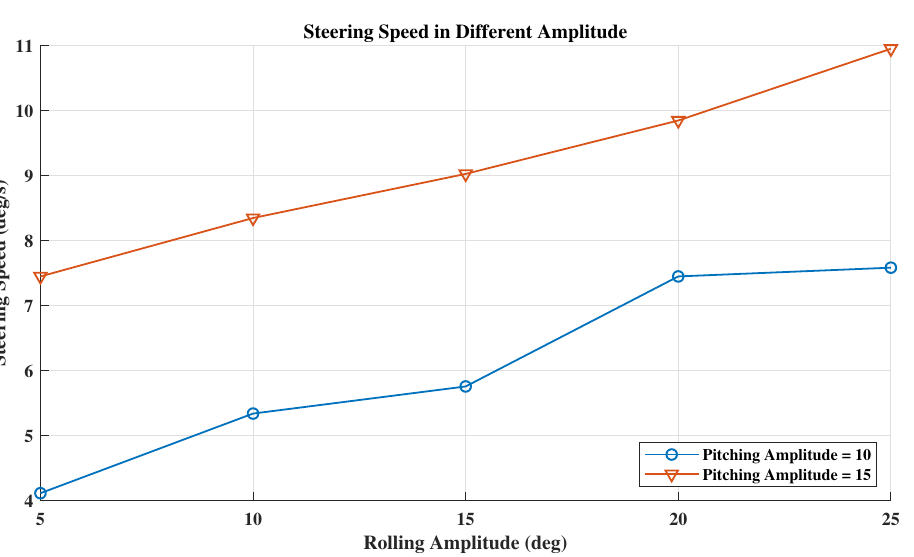
Figure 19. Steering speed in different